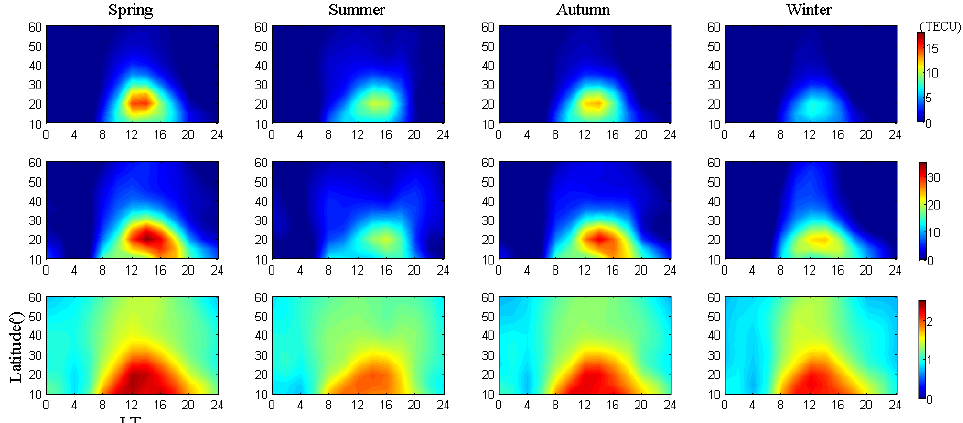
Figure 8. Two-dimensional distribution of bottom-side TEC (top panels), topside TEC (middle panels) and plasmaspheric TEC (bottom panels) in 2008.